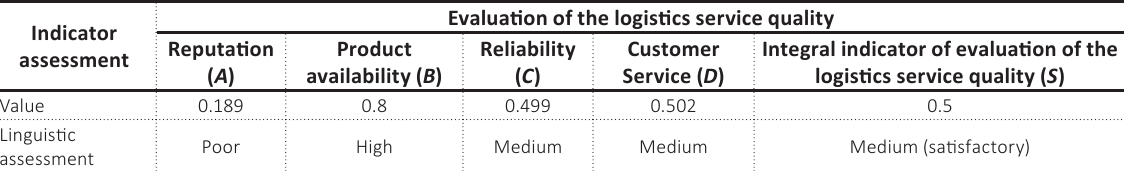
Figure 9. Defuzzification of the average values of intermediate modules to the final level of the developed fuzzy model Table 5. Average integral indicator of the logistics service